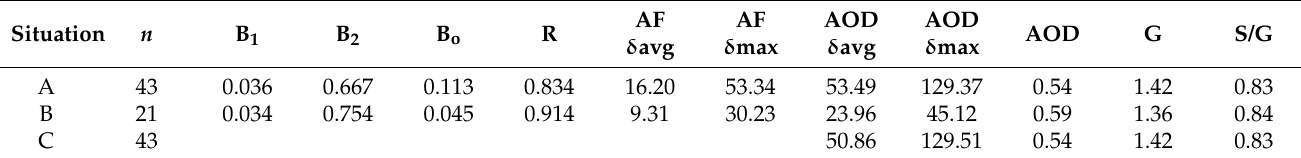
Table 9. Correlation coefficients and constants, mean relative errors for the AF and AOD (e.g., AF δ avg, AOD δ avg, %), mean values of the AOD, global solar irradiance (G, MJ m − 2 ), and S/G for different situations.